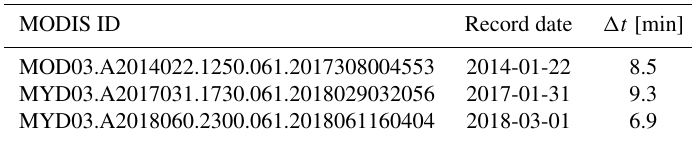
Table A1. MODIS scenes shown in Figs. 5 and 6 and record date and time difference ( (cid:49)t ) to CryoSat-2 observations in minutes (absolute value).